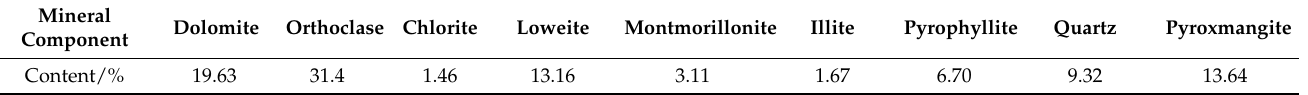
Table 1. Mineral composition and content of lamprophyre.